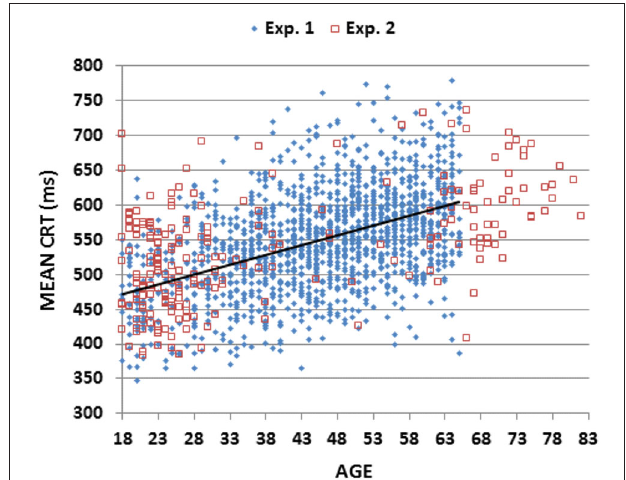
FIGURE 2 | Mean choice reaction times (CRTs) . Mean CRTs averaged over stimulus types for subjects of different ages from Experiments 1 (blue diamonds) and 2 (open red squares). The linear fit for Experiment 1 data is